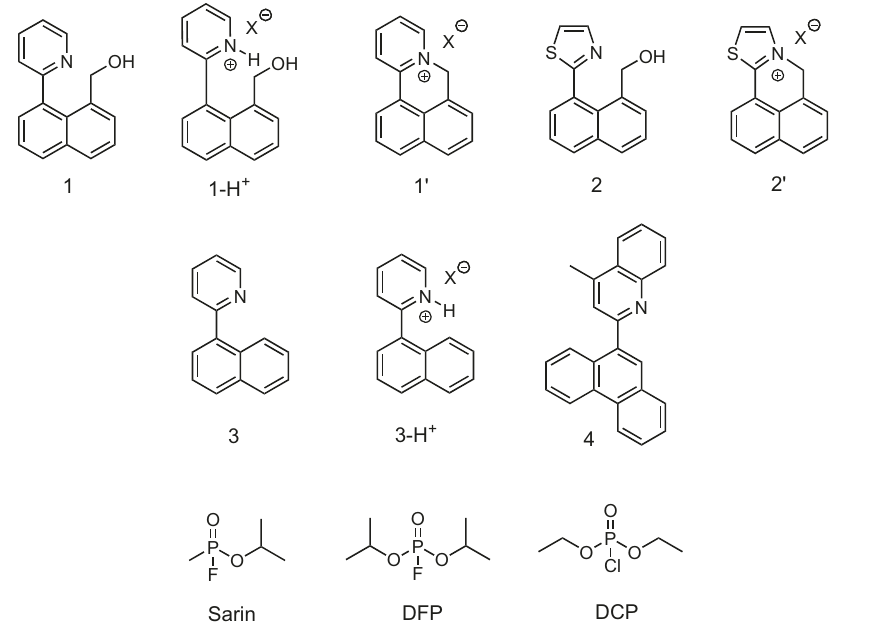
Fig. 1 Structures of the sensing compounds, proposed products and analytes. Structures of compounds 1 , 2 , 3 and 4 , the protonated forms 1-H + and 3-H + , the proposed cyclised products 1 ’ and 2 ’ , the analyte Sarin and its two simulants DFP and DCP. X is the counterion formed from the analyte vapor used.